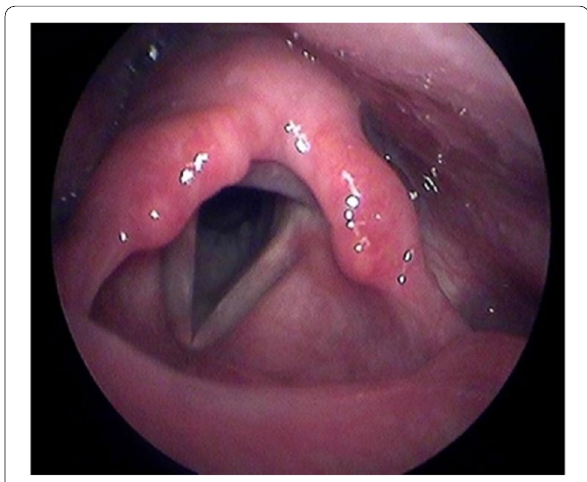
Fig. 4 A case of severe LPR showing edematous arytenoids and vestibular folds with prominent interarytenoid